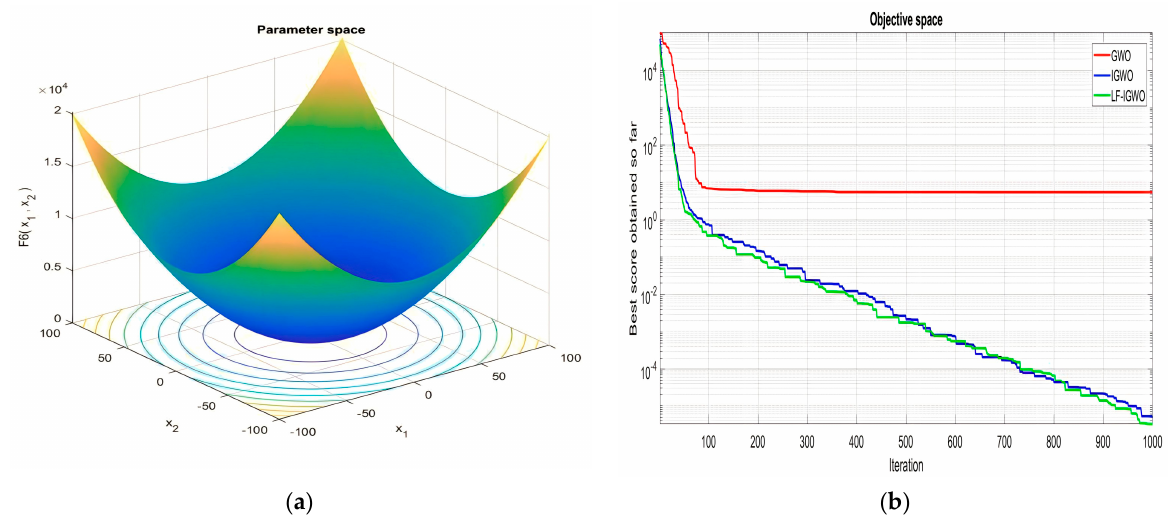
Figure 8. ( a ) Search space for unimodel function F06 ( b ) Comparison of convergence curve for F06.